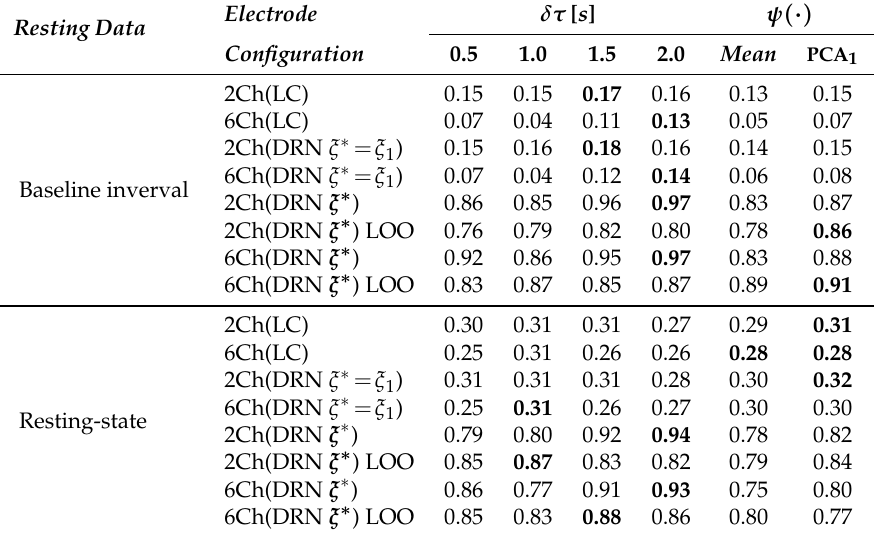
Table 1. Biserial Spearman correlation coefficient quantified between the ξ 1 indicator, extracted within different scenarios of resting data, and the accuracy response, estimated at each window length of δτ . Notations LC, DRN, and LOO stand for Linear Correlation [40], Deep Regression Network, and leave-one-out-cross validation strategy, respectively. The best value per row is marked in bold. Resting Data